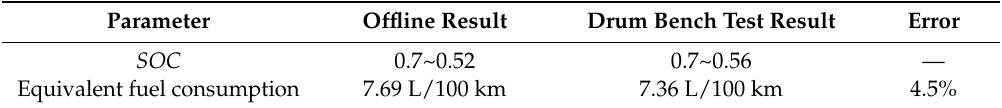
Table 10. Comparison of results from offline simulation and drum bench